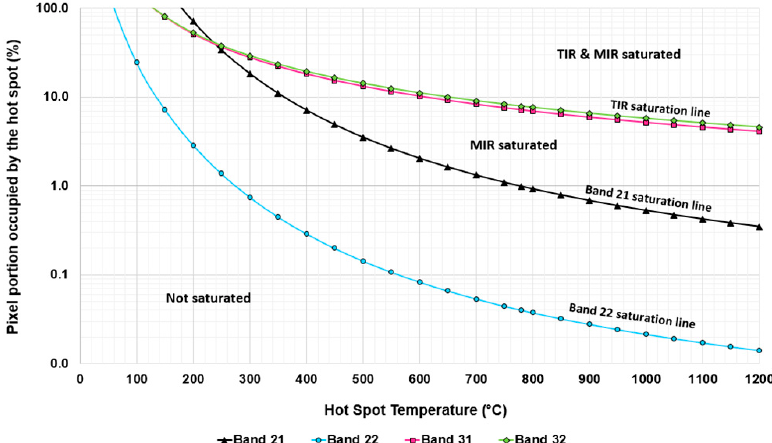
Figure 2. Temperature and size of a subpixel hot spot necessary to saturate the MIR and TIR spectral bands given a background temperature of 25 °C.